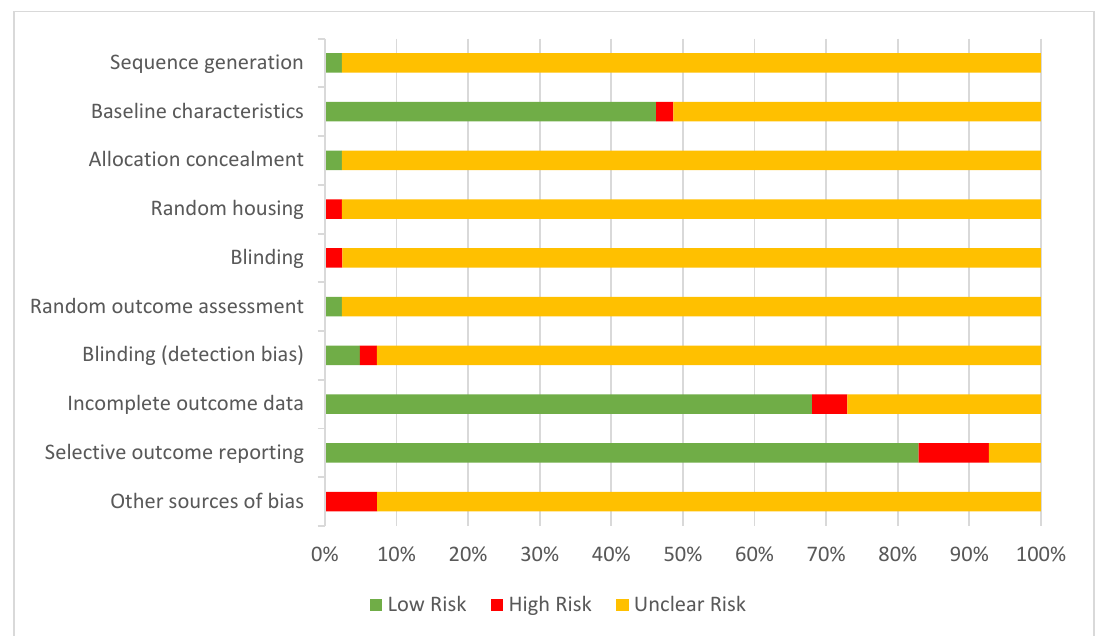
Figure 3. Risk of bias assessment using SYCRLE’s risk of bias tool.